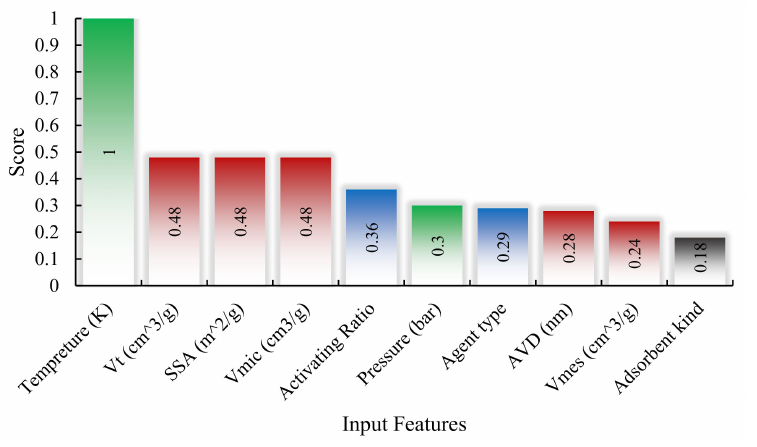
Figure 6. The relevancy score illustrates the impact of the independent variables on hydrogen storage. The green color means conditional parameters, red color means structure of characteristics, blue means chemical activation parameter, and the grey color means type of